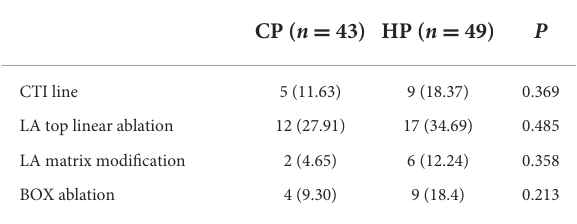
TABLE 2 Baseline patient characteristics.